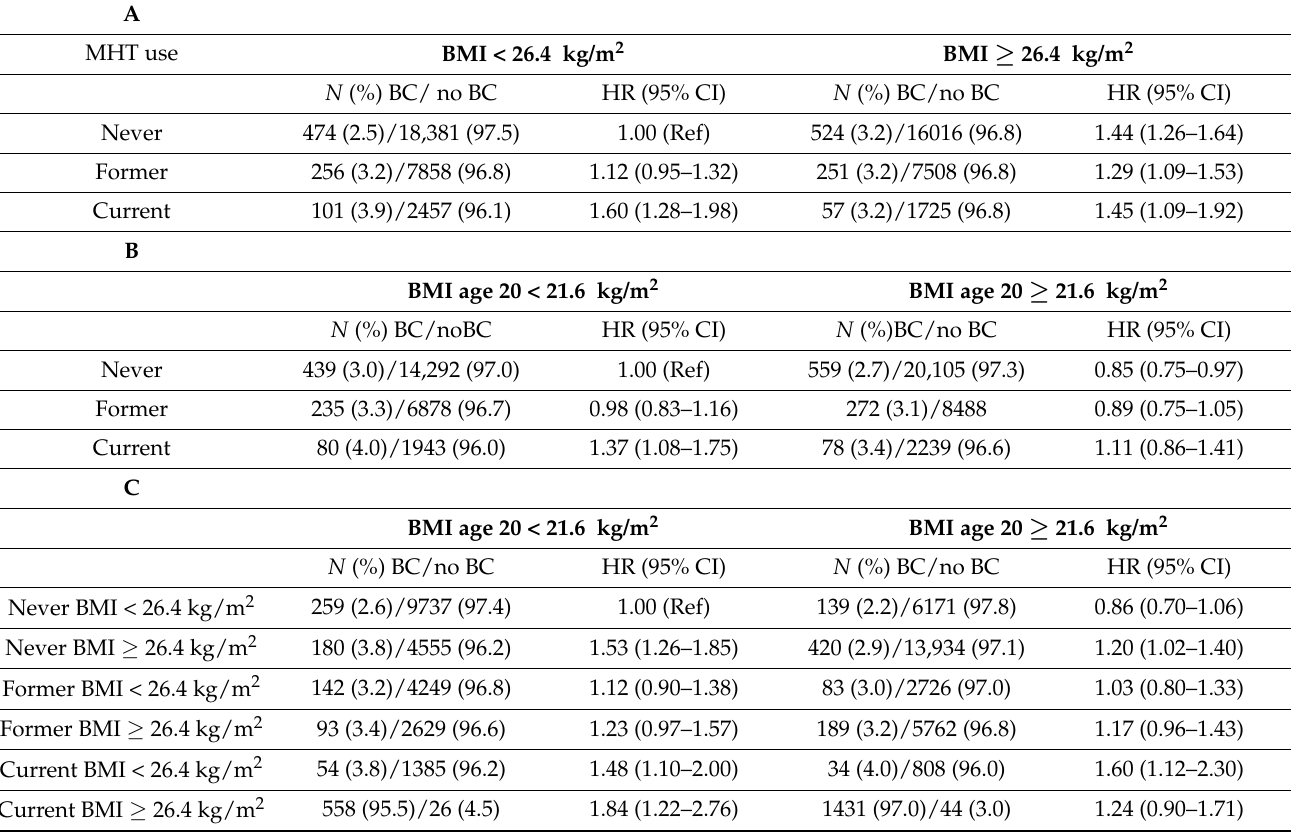
Table 1. MHT and BC risk and current and early